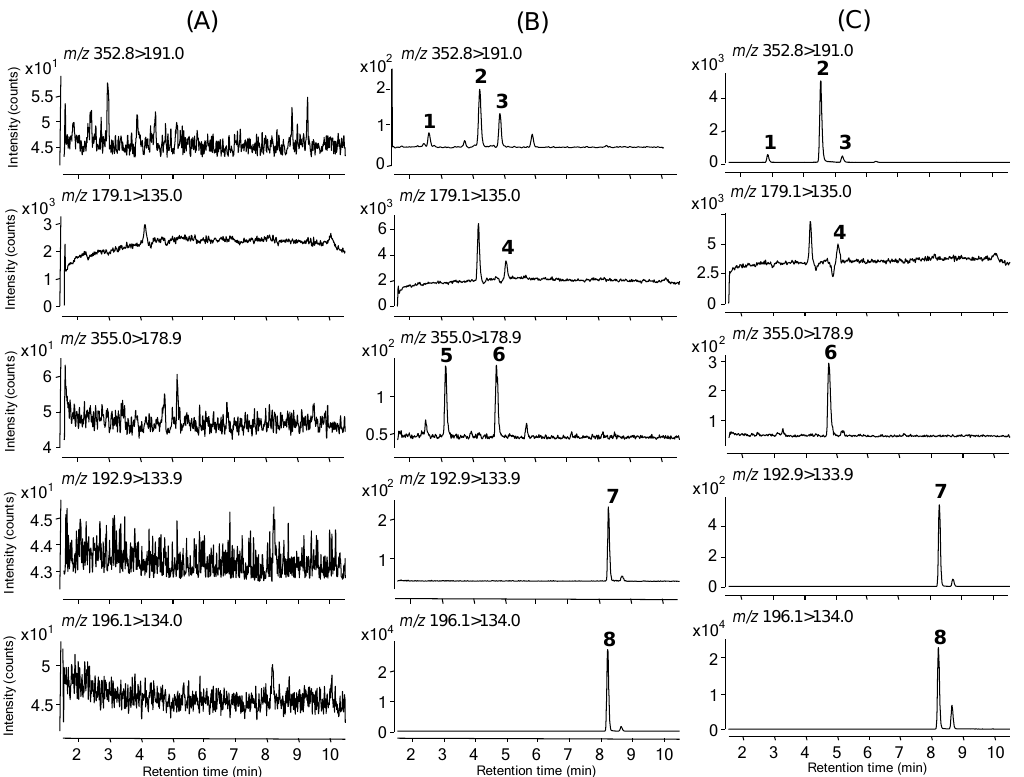
Figure 3. Selected reaction monitoring chromatograms of ( A ) rat blank plasma, ( B ) rat plasma spiked with CGA (0.5 ng/mL), NCGA (0.5 ng/mL), CCGA (2.5 ng/mL), CA (2.5 ng/mL), CA-3-G (2.5 ng/mL), CA-4-G (2.5 ng/mL), and FA (12.5 ng/mL) at lower limits of quantification (LLOQ) level, and ( C ) rat plasma obtained 5 min after oral administration of YRA-1909 at a dose of 100 mg/kg to a male SD rat. 1, NCGA; 2, CGA; 3, CCGA; 4, CA; 5, CA-4-G; 6, CA-3-G; 7, FA; 8, FA-d 3 . Table 1. Linearity, LLOQ, intra-day and inter-day accuracy (RE, %) and precision (CV, %) of CGA, NCGA, CCGA, CA, CA-3-G, CA-4-G, and FA in rat plasma quality control (QC) samples.